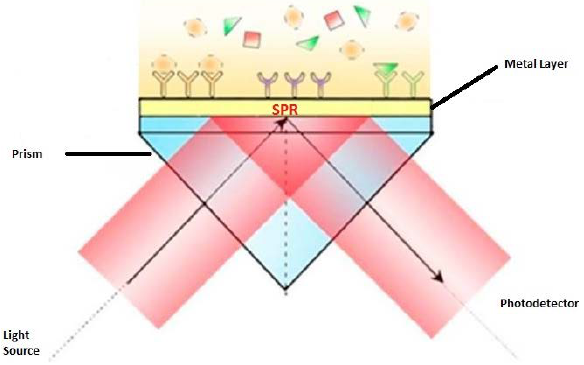
Figure 3. Configuration of SPR excitation [65].